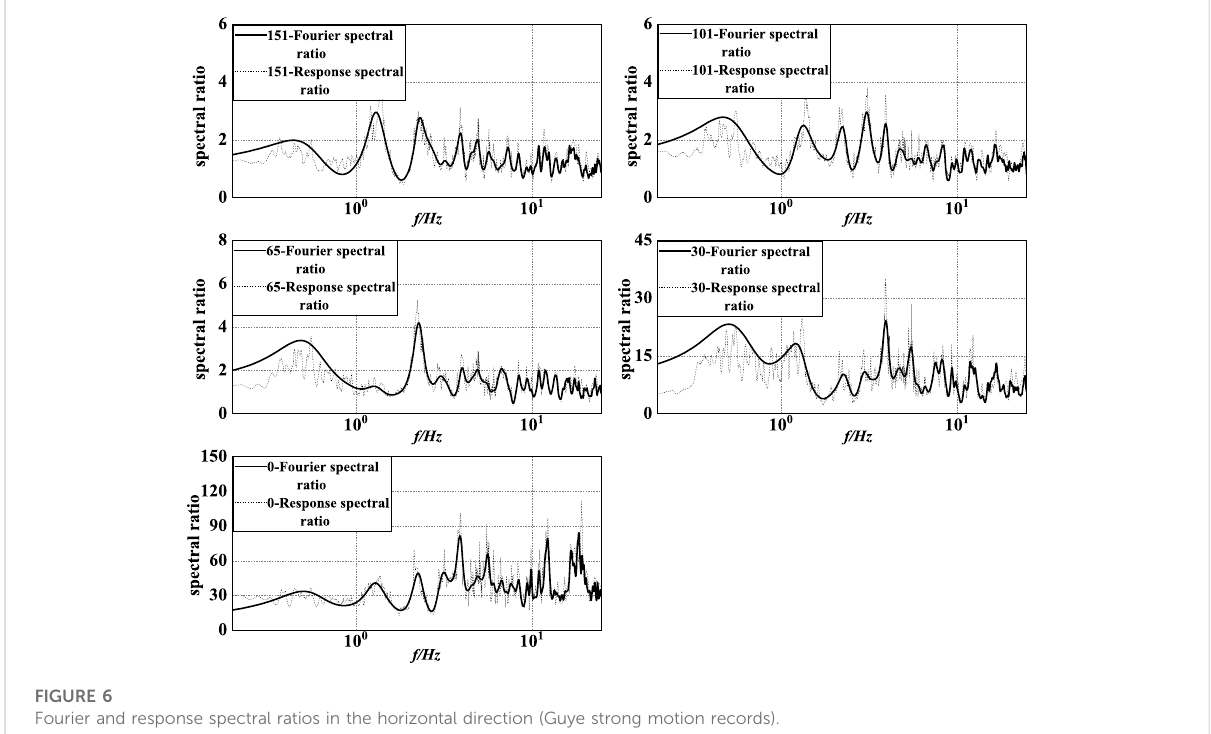
FIGURE 6 Fourier and response spectral ratios in the horizontal direction (Guye strong motion records).